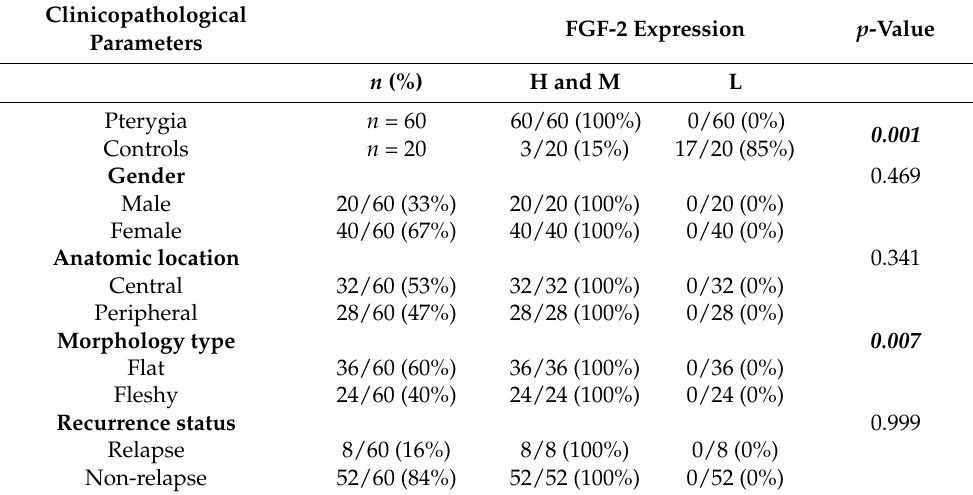
Table 1. FGF-2 expression